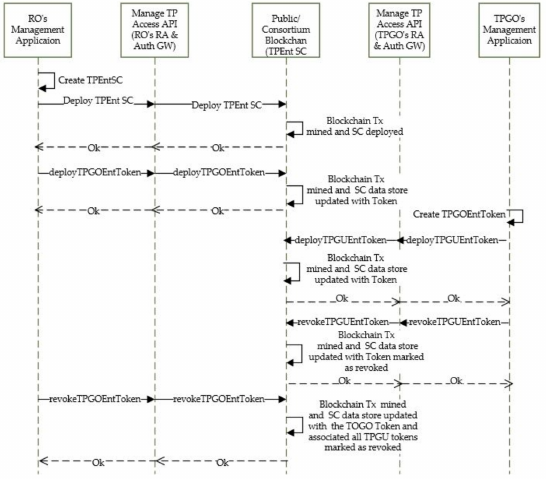
Figure 7. Setup/revoke access for TPGO and their